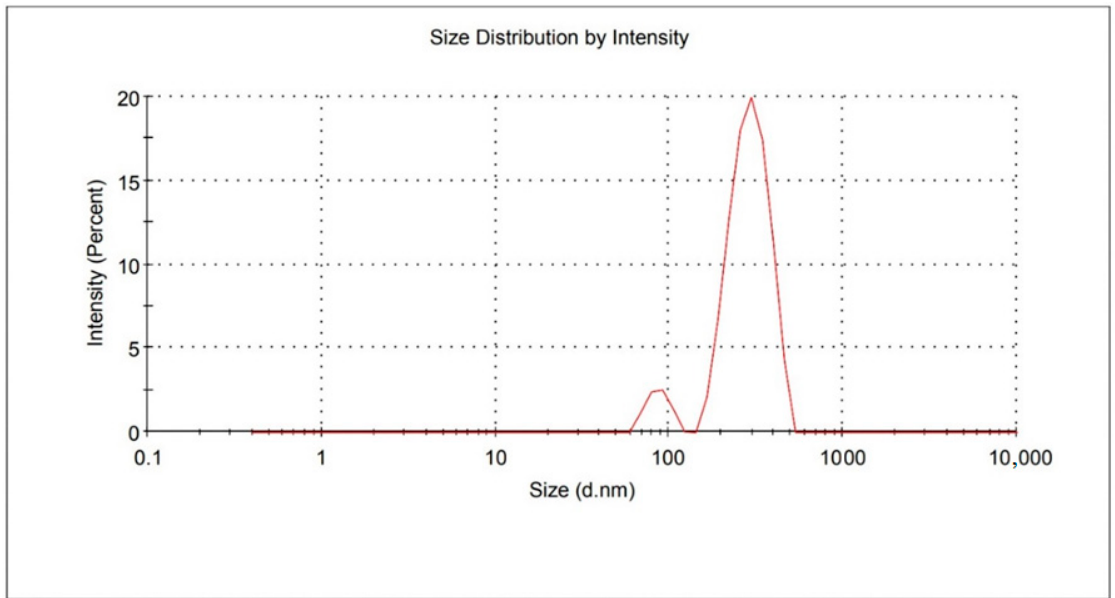
Figure 1. Mean particle size of the optimized FS3.